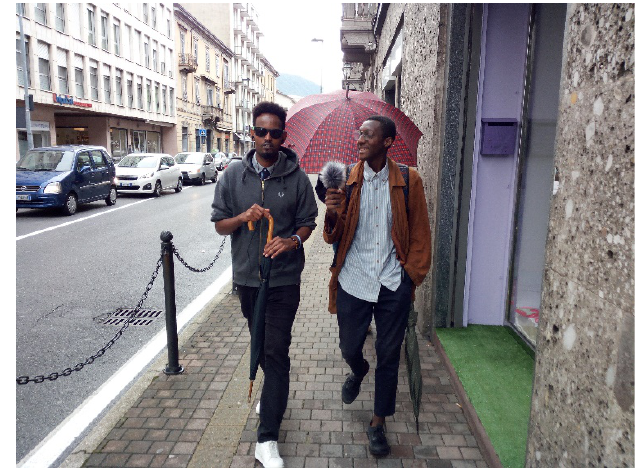
Figure 5: Abdiqani and Aziz walking in Lecco This conversation brings to surface what the social workers in our meetings called ‘the underworld’, the unexplored lives of newcomers. Differently from traditional biographic interviews, sensobiographic walks trigger more fragmentary stories, less structured by an intentional plot. These people are accustomed to formal interviews and to the need to deliver a good refugee story. Embodiment and dialogue seem to change this common discursive frame, and open space for some real